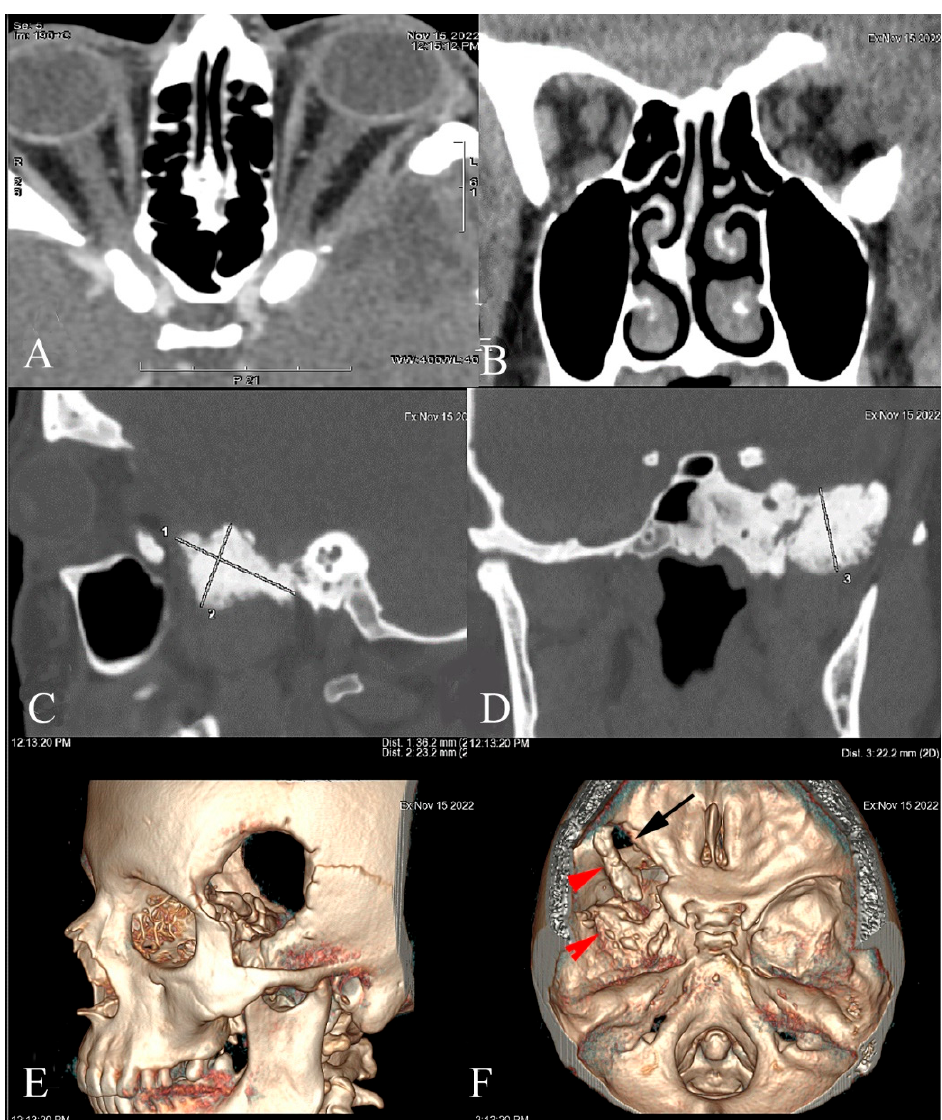
Figure 4. CT scan performed 78 months after SOM resection with orbital lateral wall removal and decompression ( A , B ). Incomplete resection, residue size 36.2 × 23.2 × 22.2 mm in the left sphenoid outside the orbit ( C , D ). Left craniotomy on 3D reconstructions ( E ), and partial resection of the sphenoid (black arrow) and SOM (red arrow) ( F